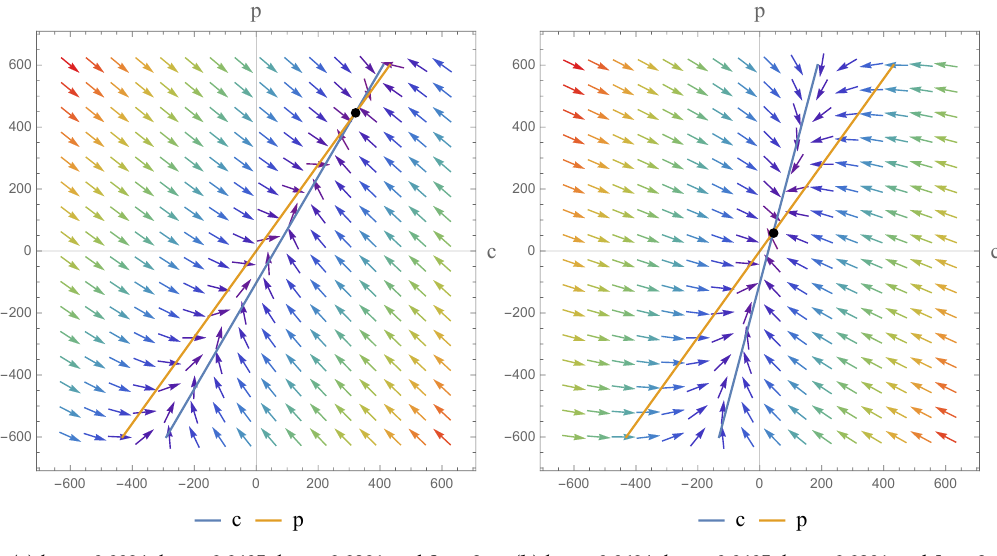
Figure 4. Phase portrait ( a ) shows the steady state concentration is directly proportional to the infusion rate ( I 0 ). Thus, a higher I 0 will result in a higher steady-state concentration, and ( b ) shows a higher elimination rate ( k 10 ) will result in a lower steady-state